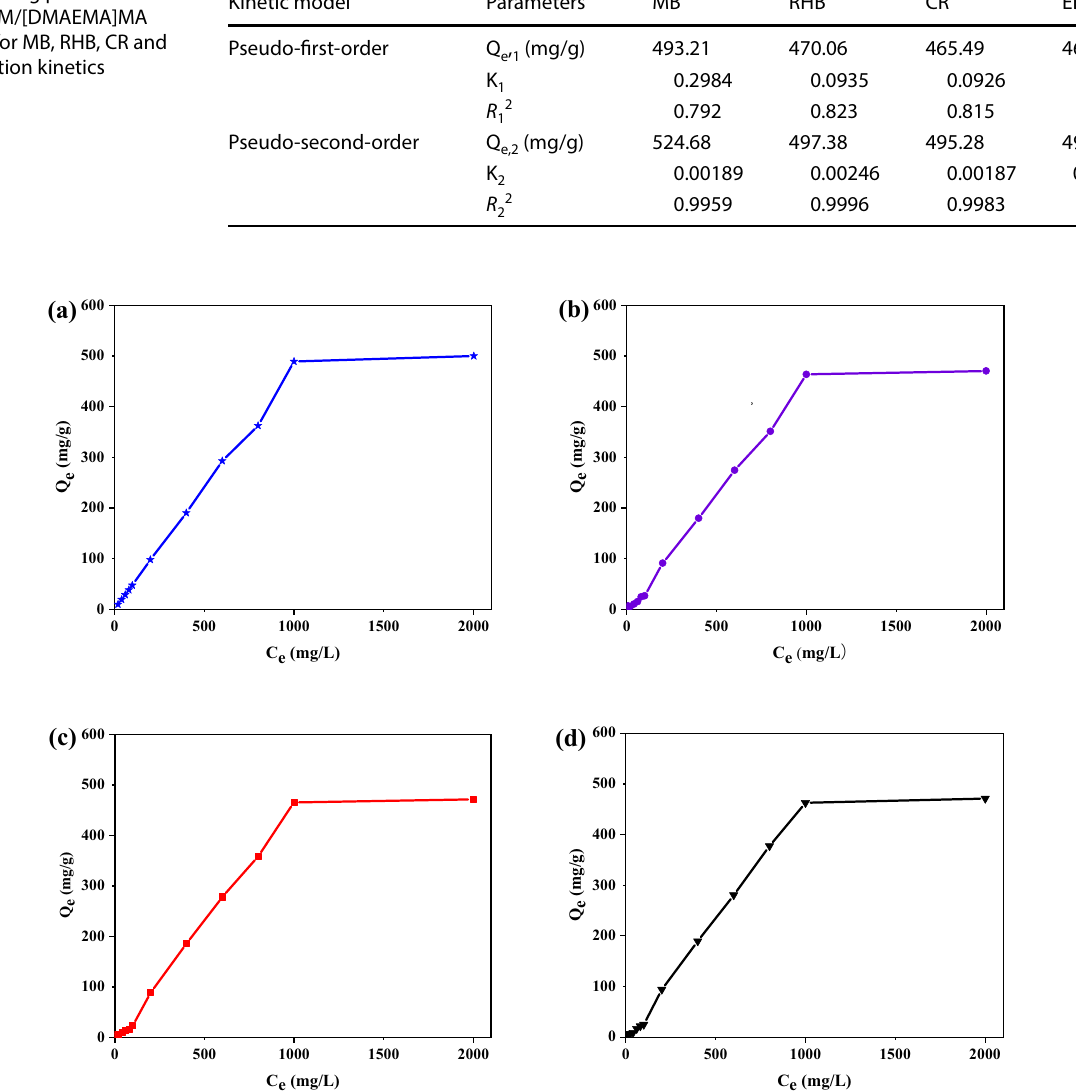
Fig. 9 a Adsorption isotherms of PAA/PAM/[DMAEMA]MA hydrogel on MB. b RHB. c CR. d